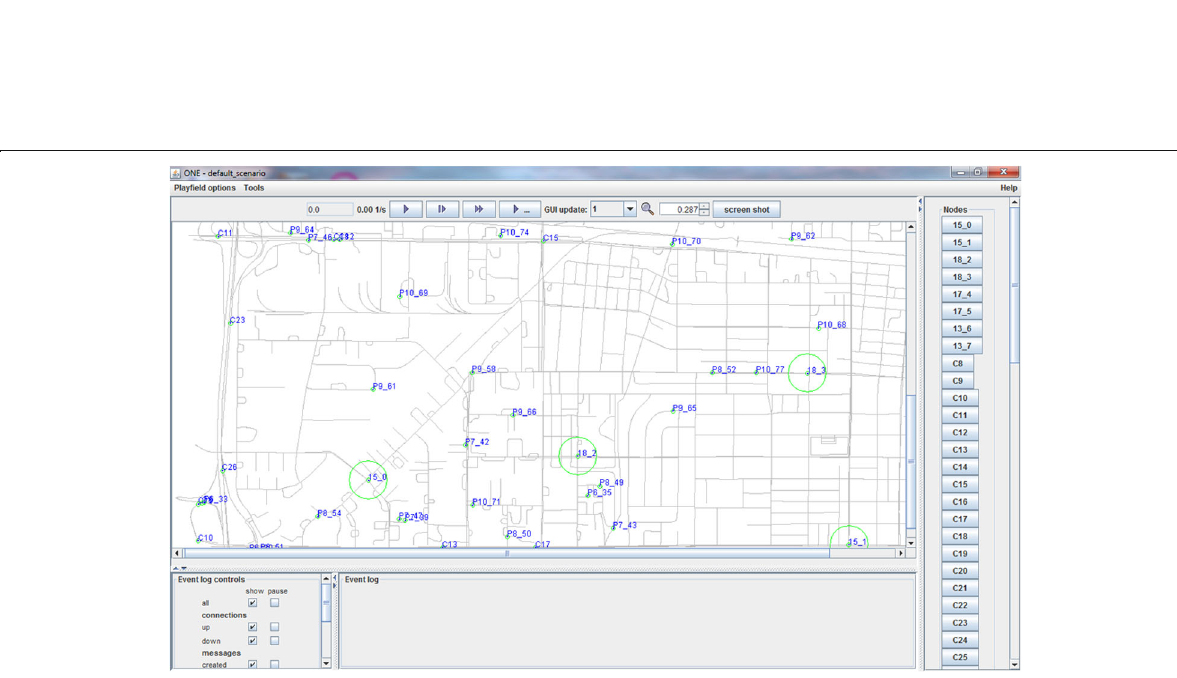
Fig. 7 A portion of map shown in ONE simulator. The circle surrounding nodes represent communication radius